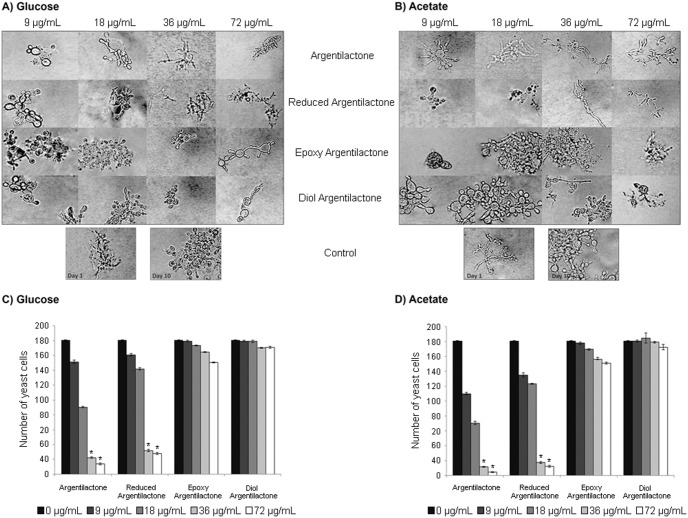
Effect of argentilactone, reduced argentilactone, epoxy argentilactone, and diol argentilactone on P. lutzii Pb01 differentiation from mycelium to yeast.The mycelium was incubated for 10 days at 36°C on MMcM agar containing glucose or acetate and supplemented with different concentrations of argentilactone, reduced argentilactone, epoxy argentilactone, and diol argentilactone. Cell morphology was observed by optical microscopy in medium containing glucose (A) or acetate (B). The P. lutzii Pb01 yeast cells were counted using a Neubauer chamber in medium containing glucose (C) or acetate (D). *p<0,05.